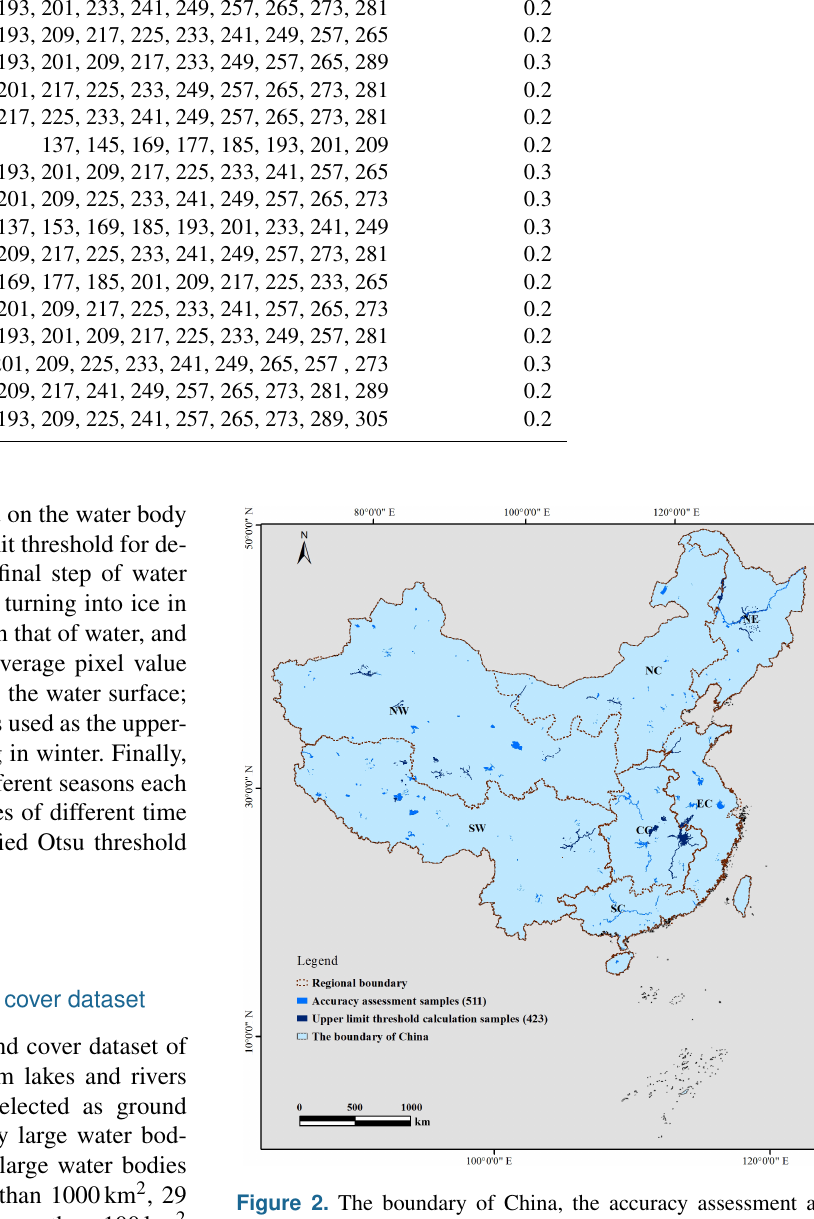
average user accuracy is 91.13 %, the average producer ac- curacy is 88.95 %, and the average kappa coefficient is 0.88 in 3 years (Table